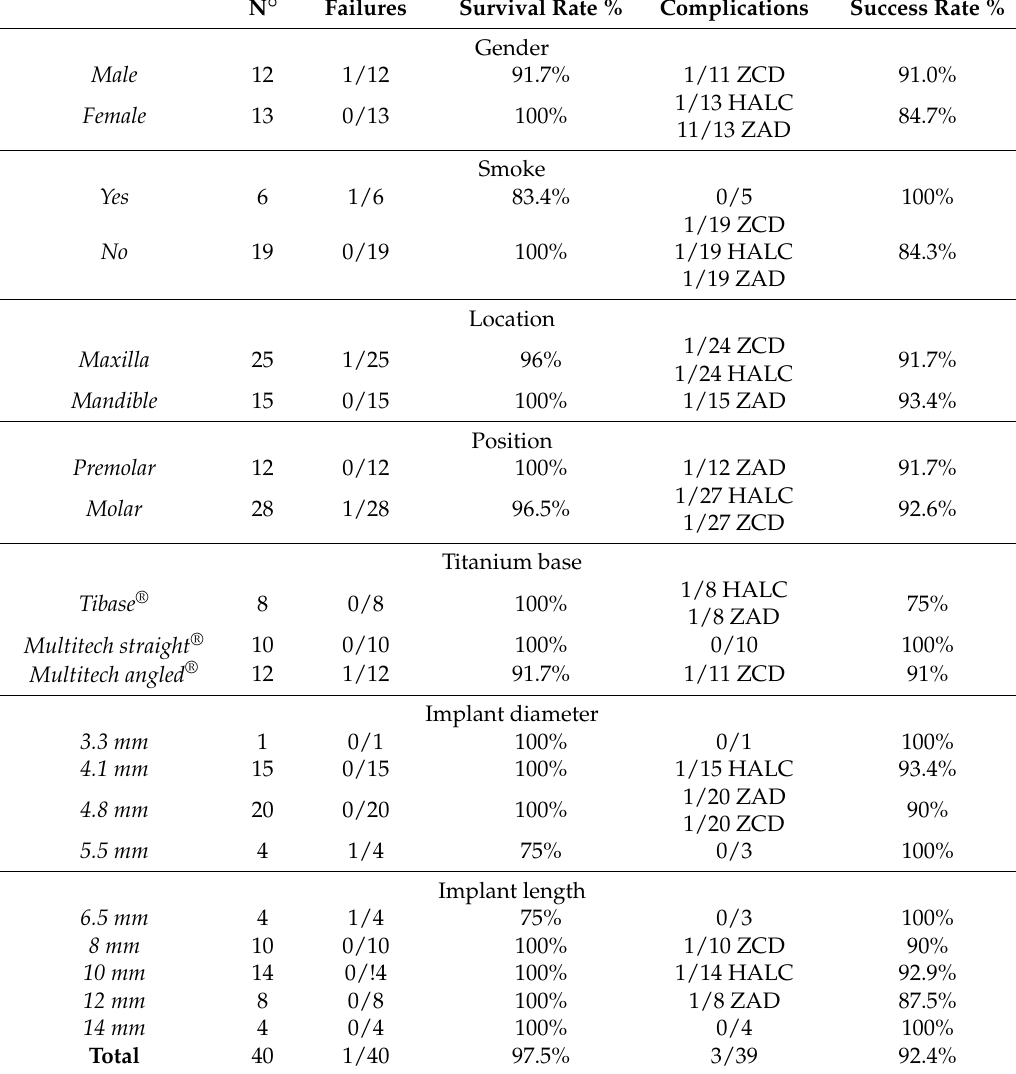
Table 2. Failures and complications affecting the implant-supported crowns, occurred during the follow-up period until the 1-year control. Among the complications there were hybrid abutment loss of connection (HALC), zirconia abutment decementation (ZAD), zirconia crown decementation